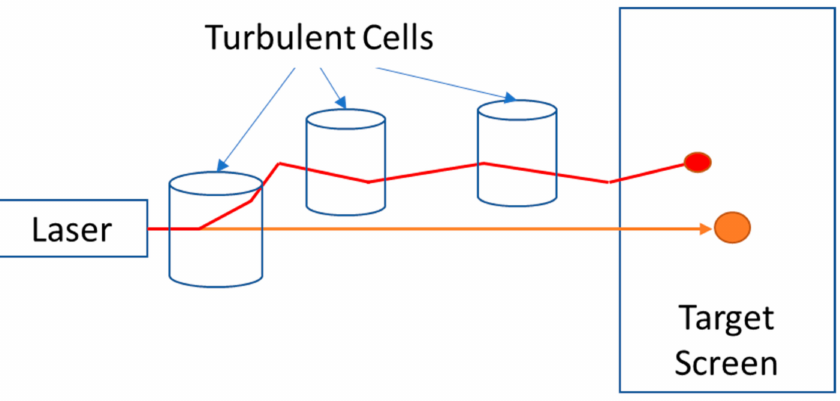
Figure 20. Beam wander as a result of laser beam deflection by turbulent cells greater than the beam diameter. Adapted from